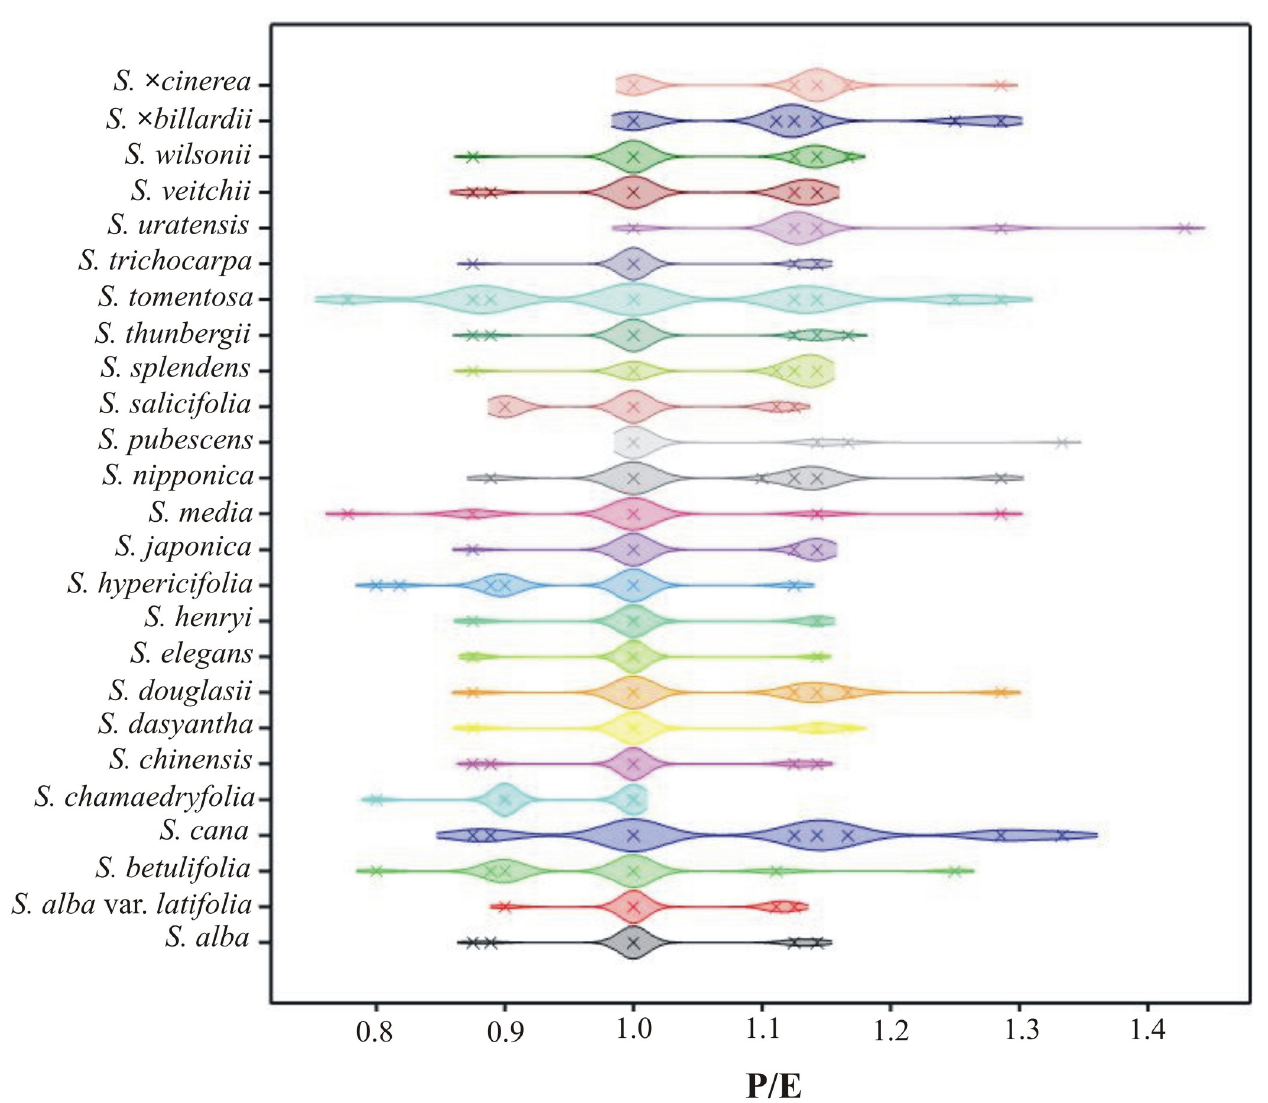
Fig 9. The density plot of P/E by Spiraea taxa. and Gataulina [38] that endoapertures of some Spiraea species can be wide ( S . hypericifolia , S . salicifolia ), while others narrow ( S . alpine , S . crenata , S . schlothaurae ). For the genus Spiraea other palynologists distinguished a striate or rarely striate-granulate exine ornamentation [23, 38, 39, 63]. Only the striate exine ornamentation was reported by Wro ń ska-Pilarek et al. [32] in S . tomentosa , while in the study presented here striate were observed in only one species, where it was the striate-reticulate ornamentation. All authors agree that the most important features of Spiraea pollen were the striae and the groove course and dimensions, as well as the presence or absence of perforations. Polyakova and Gataulina [38] reported that in the meadowsweet species the striae were variable in length and width. They crossed and branched, for the most part meridionally and in different directions. In the opinion of the above-mentioned authors, S . salicifolia was characterized by the ‘four-grooved’ pollen grains. However, such a feature was not found in the study presented here. Liu et al.